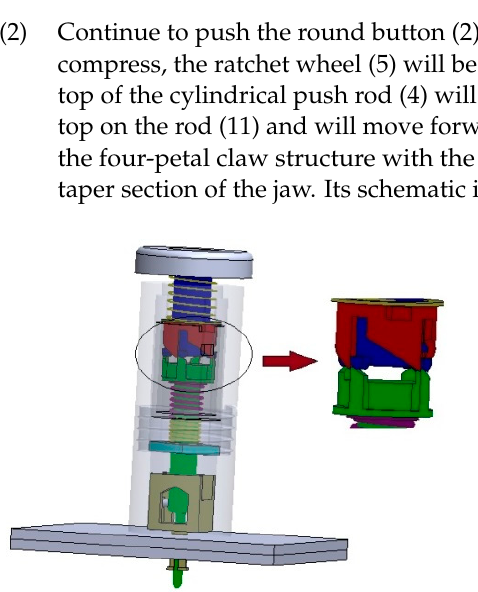
Figure 3. Schematic diagram of step 1.